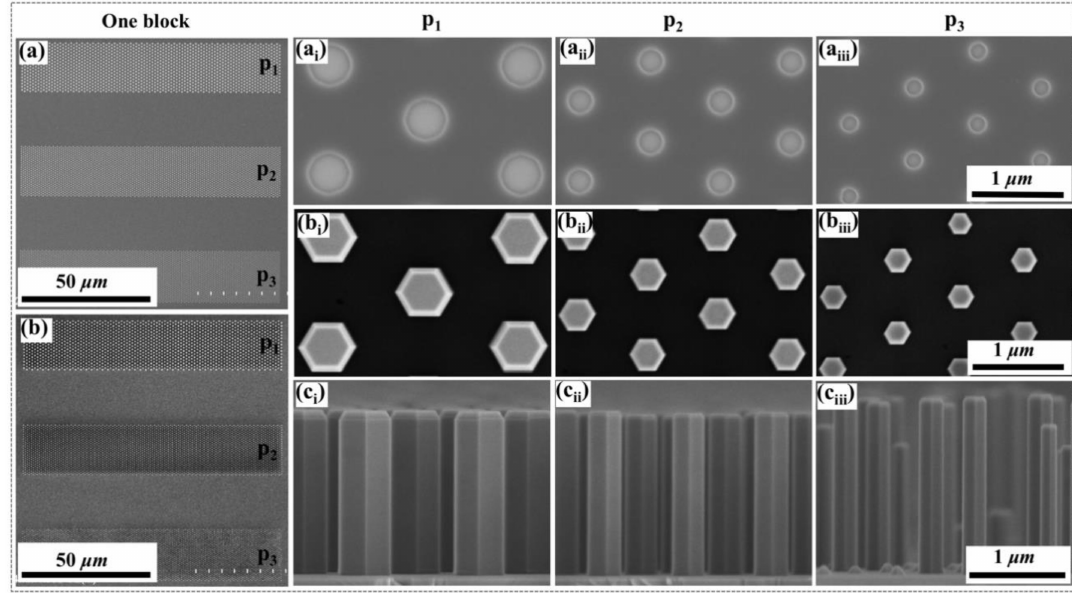
Figure 2. ( a ) SEM image of the template sample after EB lithography; Panels ( a i – a iii ) show the planar-view SEM images of the three aperture array patterns (p 1 , p 2 and p 3 ); ( b ) Planar-view SEM images of the sample after n-core NWs growth; ( b i – b iii ) Planar and ( c i – c iii ) cross-sectional view SEM images of n-core NWs in the patterns p 1 , p 2 and p 3 ,